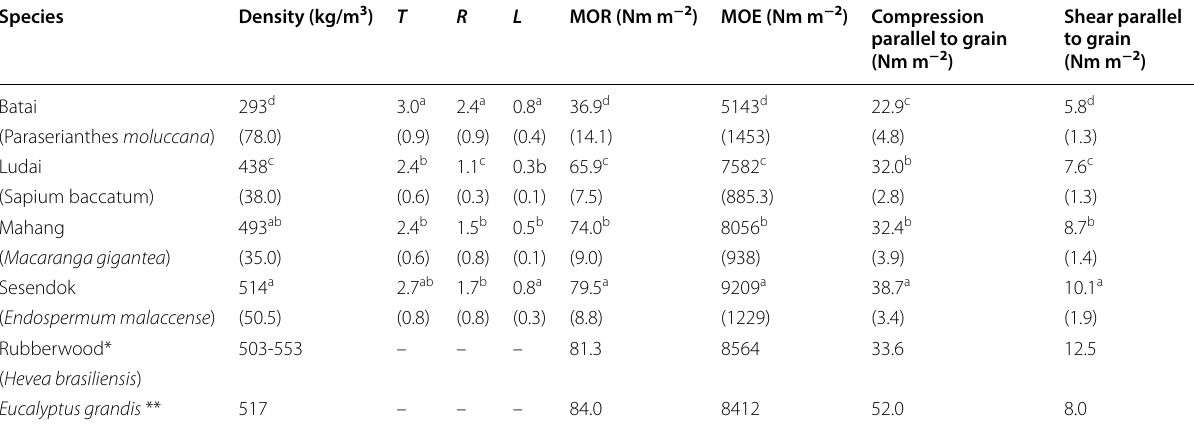
Table 2 Physical and mechanical properties of batai, ludai, mahang, and sesendok in comparison with other well-known plantation